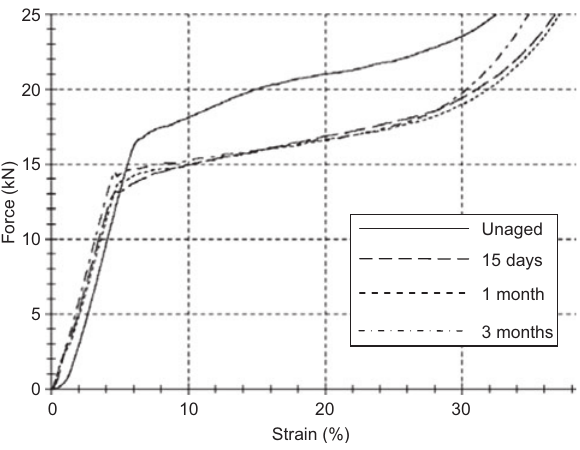
Figure 3 Compression curves of unaged syntactic foams with 55 % volume fraction GM. Figure 4 Compression curves of MS2 aged at 100 °